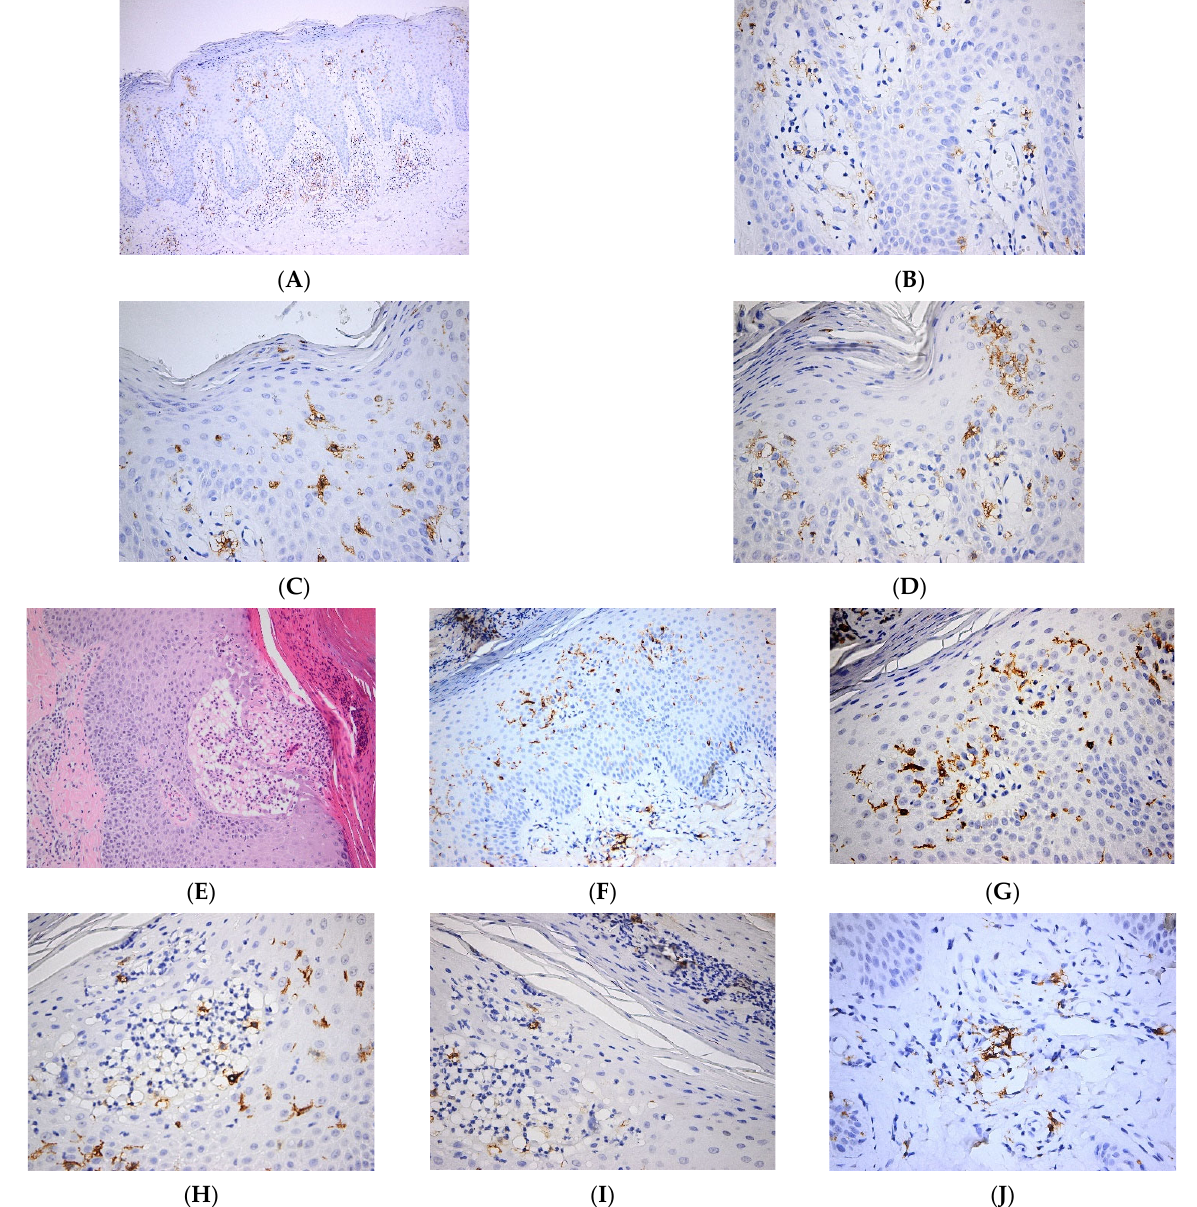
Figure 2. Langerhans cell distribution in psoriatic skin lesions. ( A ). Numerous Langerhans cells are present both within the epidermis and dermis. CD1a × 100. ( B ). Numerous Langerhans cells with perivascular distribution in papillary dermis. CD1a × 400. ( C ). Frequent intraepidermal Langerhans cells with diffuse distribution in the whole epidermal layer. Occasional Langerhans cells within the parakeratotic layer. CD1a × 400. ( D ). Frequent intraepidermal Langerhans cells with a predomi ‐ nantly basal/suprabasal location. Few Langerhans cells present in the corneous layer. CD1a × 400; ( E – J ). Pustulous psoriasis. ( E ). Thick epidermis with subcorneous vesicle filled by serum containing neutrophils; suprajacent agranulosis; marked parakeratosis with neutrophilic abscess; keratinocytic proliferation HE × 100. ( F ). Numerous Langerhans cells within the epidermis and papillary dermis. CD1a × 100. ( G ). Numerous Langerhans cells with predominantly basal/suprabasal location. CD1a × 400. ( H ). Numerous intraepidermal Langerhans cells are present both within the subcor- neous vesicle and in the adjacent epidermis. CD1a × 400. ( I ). Frequent intraepidermal Langerhans cells present in the parakeratotic corneous layer. CD1a × 400. ( J ). Perivascular Langerhans cells in papillary dermis. CD1a ×